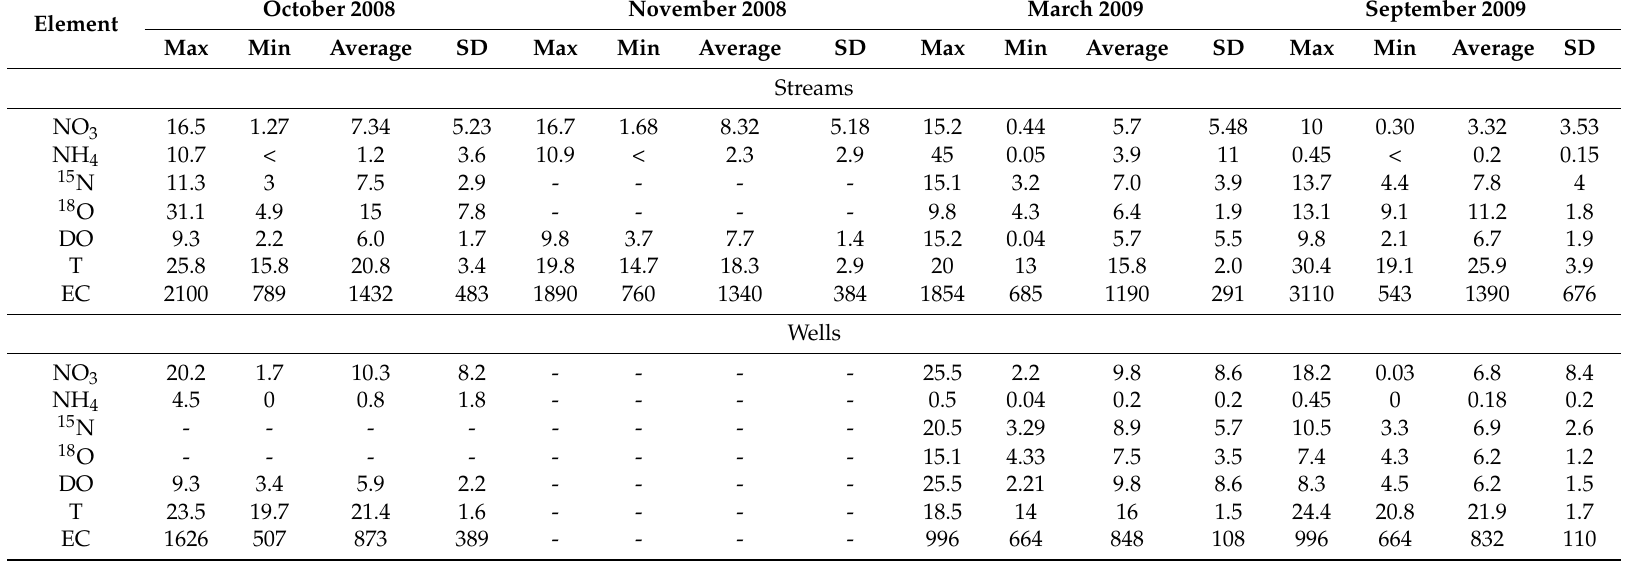
Table 2. Measured values (mg · L − 1 ) for nutrients (nitrate-nitrogen, ammonium-nitrogen) and dissolved oxygen, ( ‰ ) for stable isotopes, ( µ S · cm − 1 ) for electrical conductivity and ( ◦ C) for temperature. Descriptive statistics of chemical variables in the stream water, shallow groundwater, and pore water samples during the